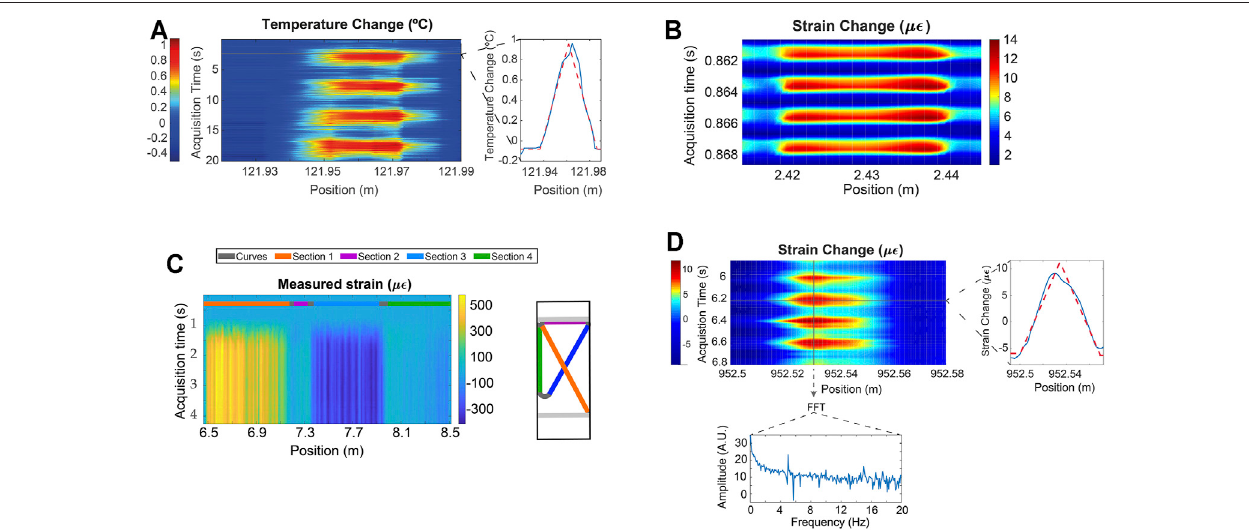
FIGURE 2 | Experimental results obtained from the TE- Φ OTDR technique: (A) Detection of temperature variations with resolution of 2 cm, sampling frequency of 20 Hz and range of 200 m. The inset shows the spatial-domain shape of the detected perturbation, which corresponds to the convolution of a square-shaped perturbation pro fi le and the 2 cm resolution. (B) Measurement of strain perturbation with resolution of 2 cm, sampling frequency of 2 kHz and range of 10 m, using a specially designed quadraticspectralphase modulation. (C) Torsionofamodel ofwing ofan unmanned aerial vehicle.The fi ber cable wasgluedon the wingusing thetopologyshownintheinsetof fi gure. (D) Measurementofaperiodicstrainperturbationwithresolutionof4 cm,samplingfrequencyof40 Hzandrangeof1 km,using thequasi-integerratiodualcombcon fi guration.Insetattherightshowsthespatial-domaindetectedpro fi leandinsetatthebottomshowsthefastFouriertransform(FFT) measured at the marked position of the strain